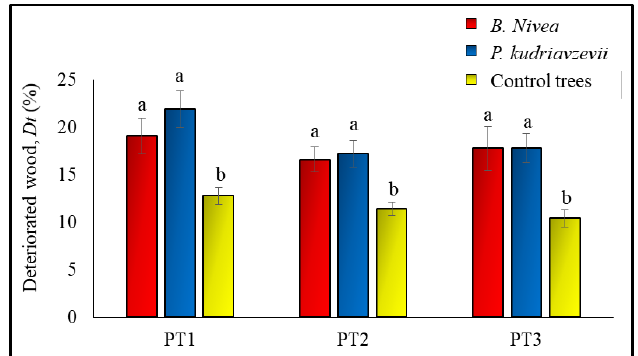
Figure 9. Dt % in the sapwood of A. malaccensis tree in different inoculation positions. PT1 = bottom position, PT2 = middle position, PT3 = top position . The error bar represents the mean standard error (n = 27); distinct letters imply significant distinctions between inoculation treatments following Duncan’s multiple comparison test ( p < 0.05).